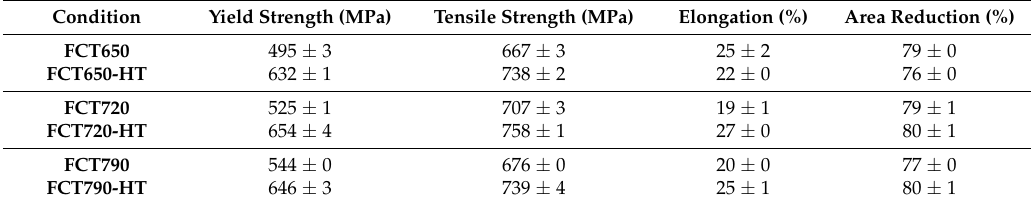
Table 2. Yield strength (YS), tensile strength (TS), elongation (%), and area reduction (%) values for